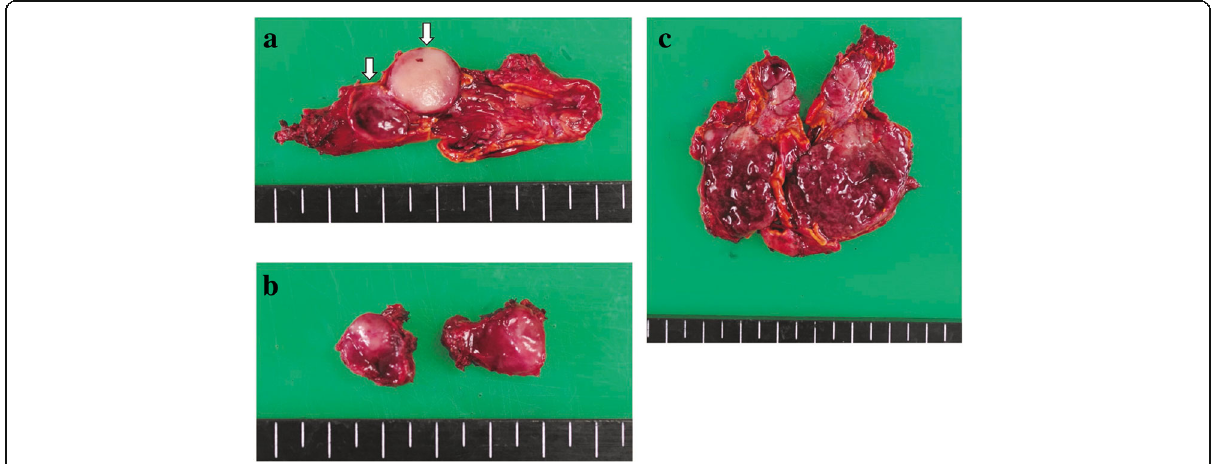
Fig. 2 a Left adrenal gland resected in the first operation. Multifocal nodules were observed in cross-section (shown by white arrows), and whole adrenal medulla thickened. b The cross-section of the left renal hilus tumor resected in the first operation. c Right adrenal gland resected in second operation. The adrenal medulla thickened, and the cortex was